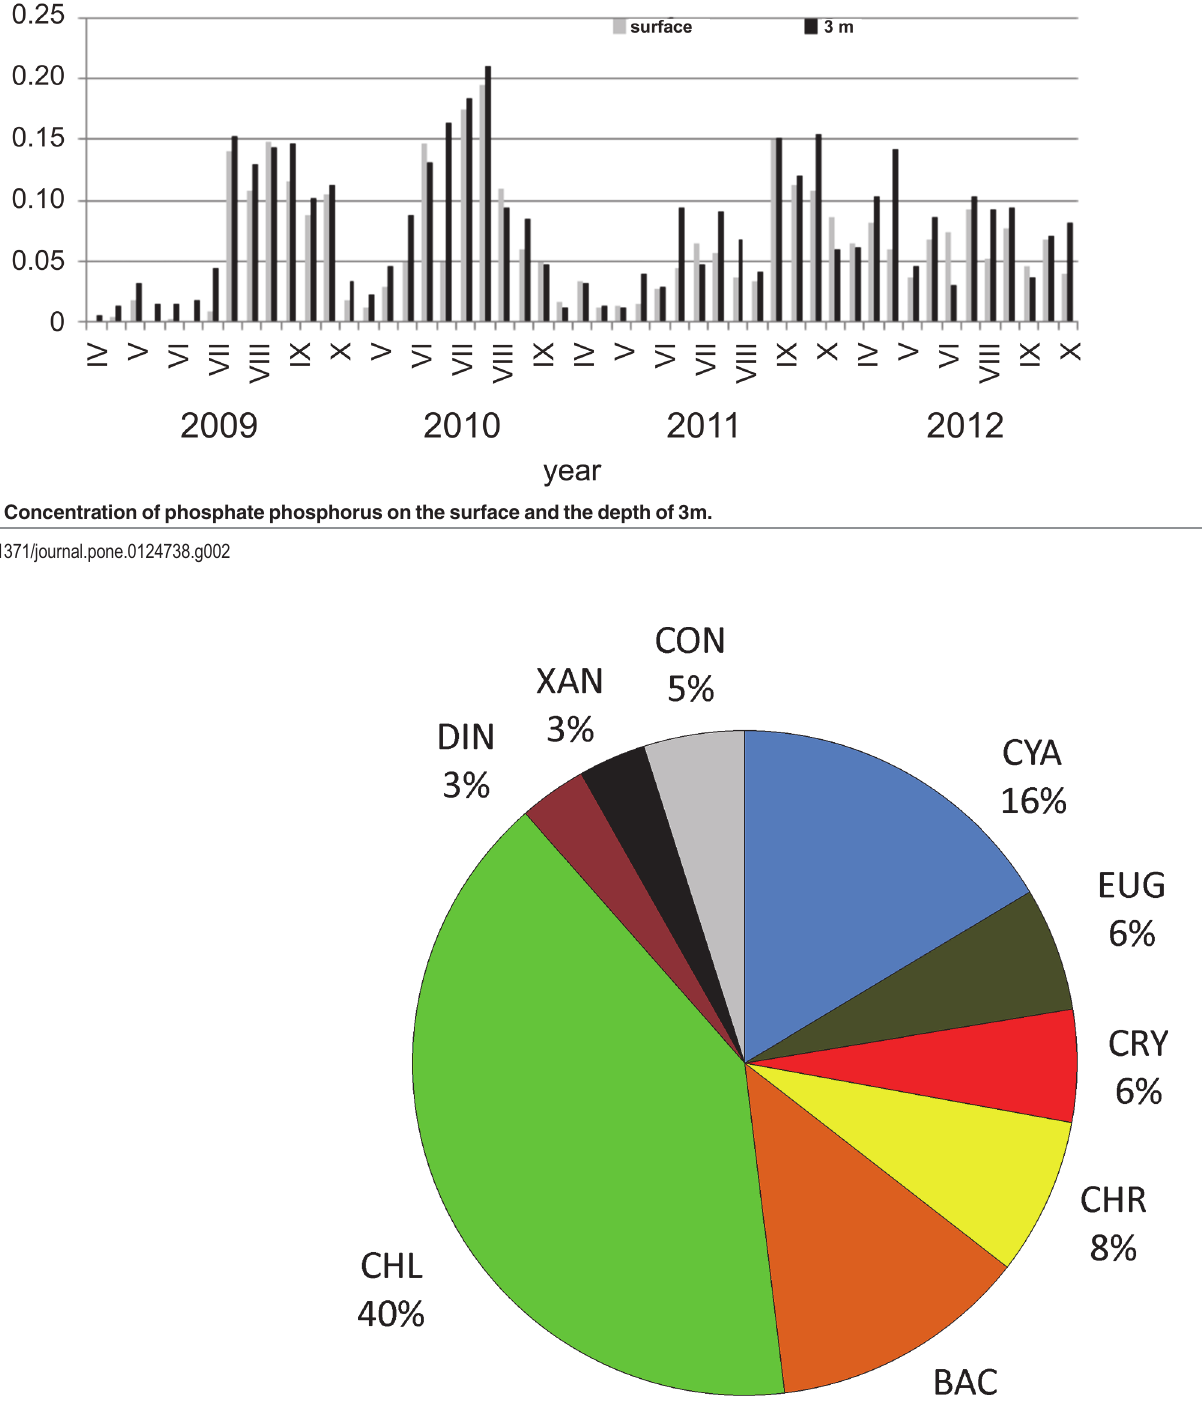
PLOS ONE | DOI:10.1371/journal.pone.0124738 April 23,